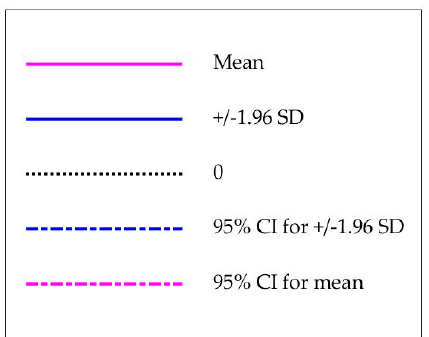
Figure 5. Bland–Altman plots comparing the average of the weekend days and the weekdays for the ( a ) average leg movement rate, ( b ) average leg movement duration, ( c ) average acceleration of leg movement, and ( d ) peak acceleration of leg movement.